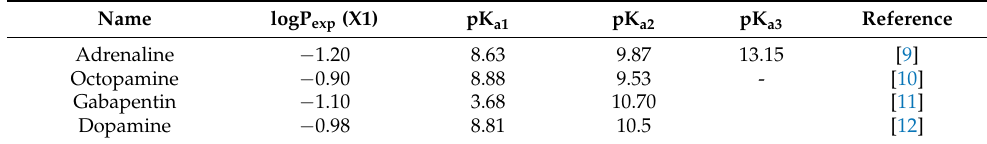
Table 1. Hydrophobic and acid-base properties of studied biogenic